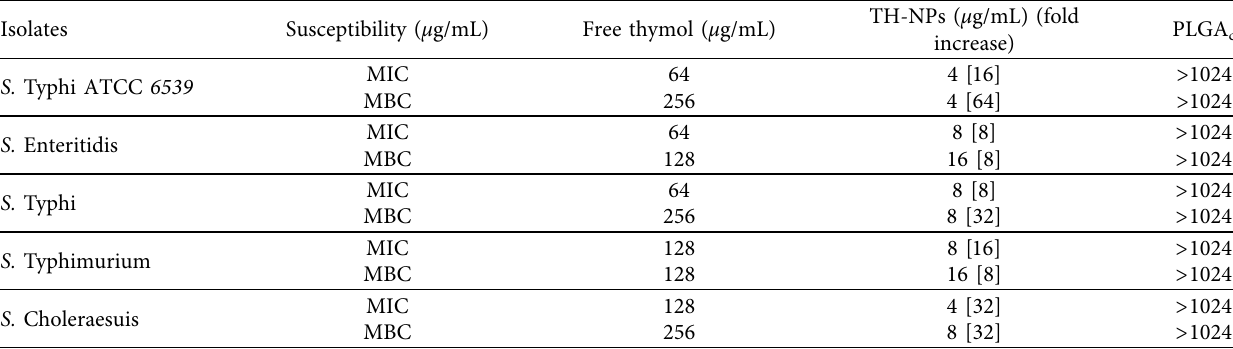
Table 1: Susceptibility of S. enterica planktonic cells against free thymol, thymol-loaded PLGA nanoparticles (TH-NPs), and the copolymer of PLGA.